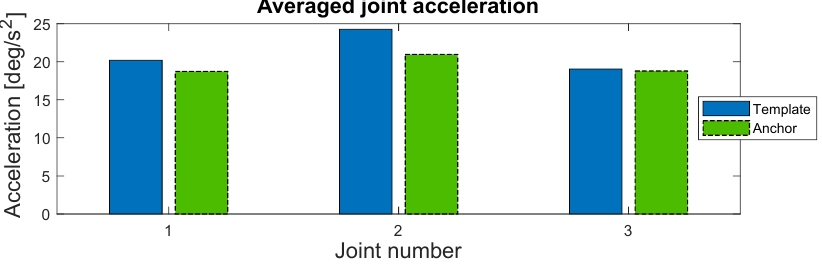
Figure 14. Accelerations of the three motors during a gait cycle for both the template and anchor